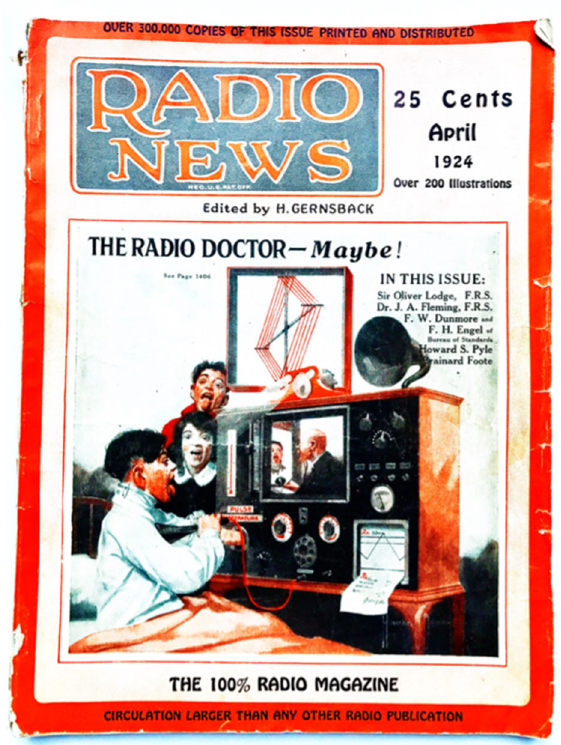
Fig. 1 Early telemedicine concept. This is an early conception of telemedicine from Radio News, April 1924. (Radio News is a defunct American magazine, 1919 – 1971, of which the copyright has